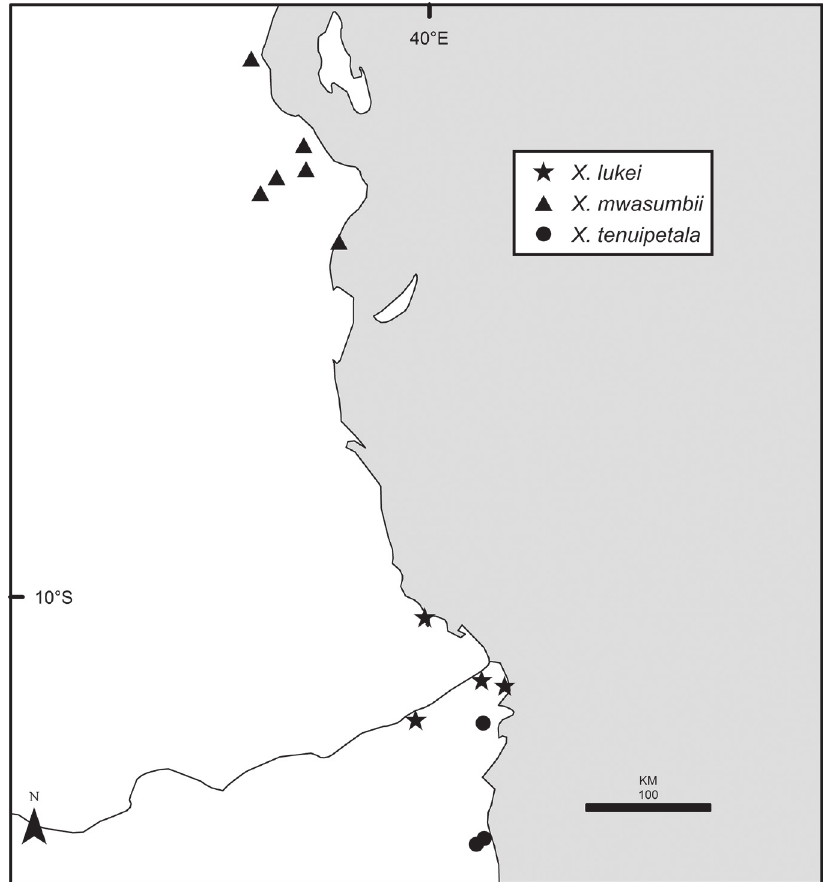
Figure 19. Distributions of Xylopia lukei , X. mwasumbii , and X. tenuipetala in eastern Africa. Bold lines represent country